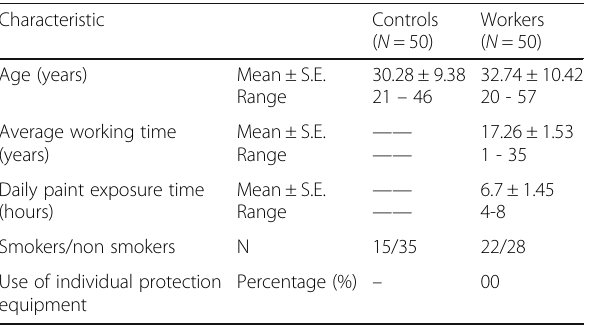
Table 1 Demographic characteristics of the study groups